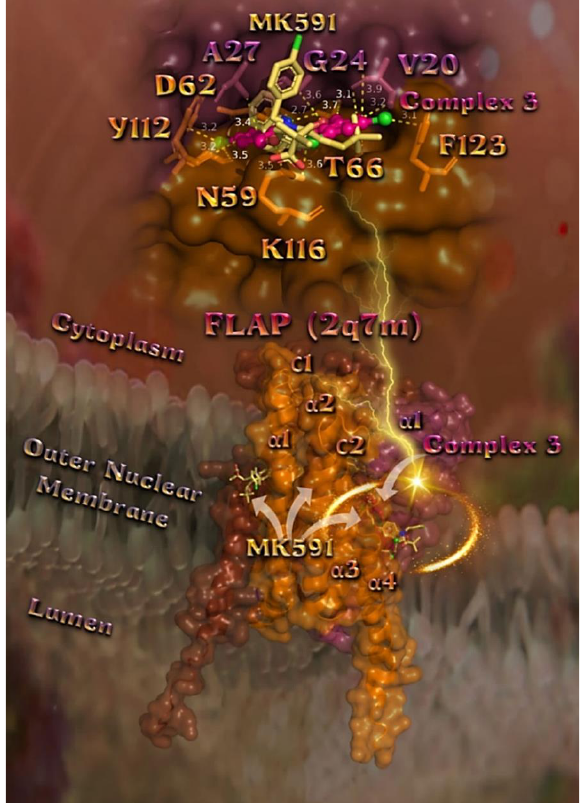
Figure 11. ( Lower panel ) Docking pose orientation of best-bound complex 3 on the crystal structure of FLAP (PDB: 2q7m) bound with FLAP inhibitor MK-591. The target protein is a homotrimer folded into three domains, illustrated as a cartoon and colored by the chain in orange, raspberry, and chocolate for the three domains d (catalytic), e (C-terminal), and f (N-terminal), respectively, between which the catalytic center is located, with the additional depiction of semi-transparent surface colored according to cartoon. FLAP trimer protein is localized at the outer nuclear membrane with each monomer composed of four transmembrane α -helices connected by two cytoplasmic loops and one lumenal loop. Complex 3 is docked at the same binding pocket with co-crystallized drug MK-591. Complex 3 and MK-591 are rendered in ball-and-stick and stick mode, respectively and colored according to atom type in hot pink and yellow-orange, respectively. The lowest energy binding pose of 3 is stabilized at the center of the catalytic site in an intermonomeric cleft between domains d and e formed by helices α 1 of chain e (raspberry), and α 2, α 4 of chain d (orange). Lumen indicates the perinuclear space between outer and inner nuclear membranes. ( Upper panel ) A close-up view of the binding pocket of 3 in the crystal structure of FLAP. The target protein is depicted as a semi- transparent surface colored according to the cartoon. Complex 3 is illustrated to be anchored at the same place with MK-591 (both rendered and colored as in the lower panel), with the additional depiction of selected contacting residues of the binding pocket rendered in a stick model and colored according to the chain. Binding contacts are shown as dotted yellow lines. Heteroatom color-code: O: red, N: blue, Cl: chartreuse green, Pd: grey. Hydrogen atoms are omitted from all molecules for clarity. The final structure was ray-traced and illustrated with the aid of PyMol Molecular Graphics Systems. Binding contacts shown as dotted yellow lines are mentioned in Table